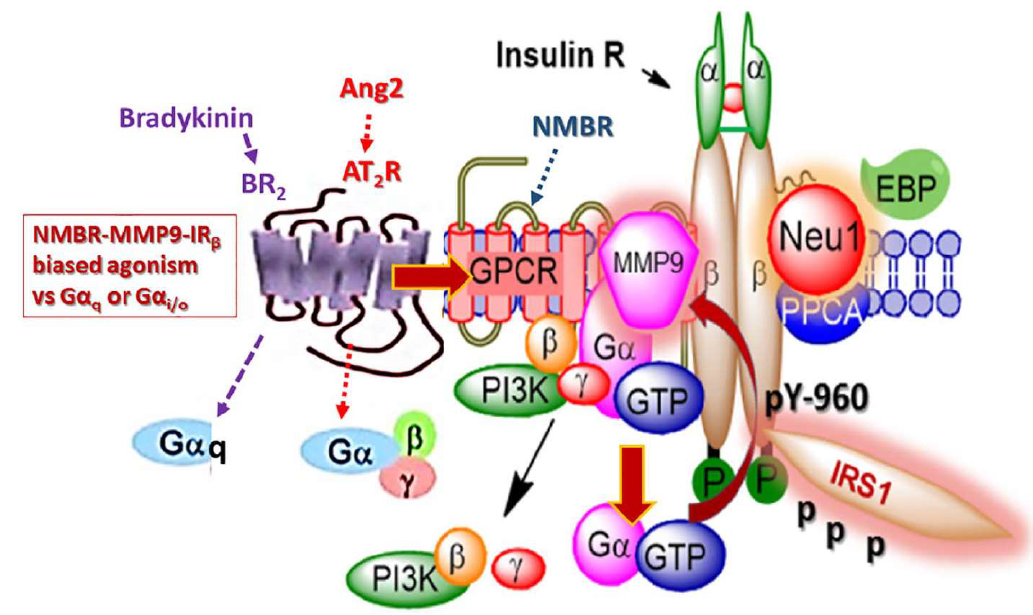
Figure 3. Mechanism of GPCR bias agonism involves insulin receptor activation. Bradykinin and angiotensin II form a complex with the neuromedin B receptor (NMBR), IRβ, and Neu-1. Bradykinin and angiotensin II preferentially lead to insulin-receptor signaling by first forming a complex with NMBR. This heterodimerization leads Gα, β, and γ to activate MMP-9. Upon activation, MMP-9 removes EBP, which in turn activates Neu-1. Crosstalk between these activated components leads to the phosphorylation and subsequent activation of insulin receptor substrate 1 (IRS1), initiating the phosphoinositide 3-kinase-protein kinase B (PI3K–AKT) pathway, in addition to others, without